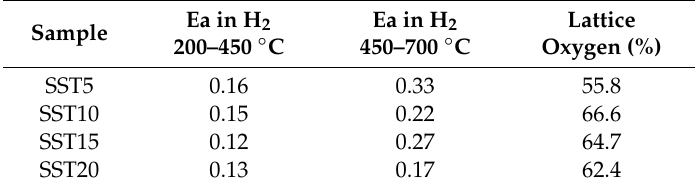
Table 2. Activation energy and lattice oxygen content of all Sm-doped samples.